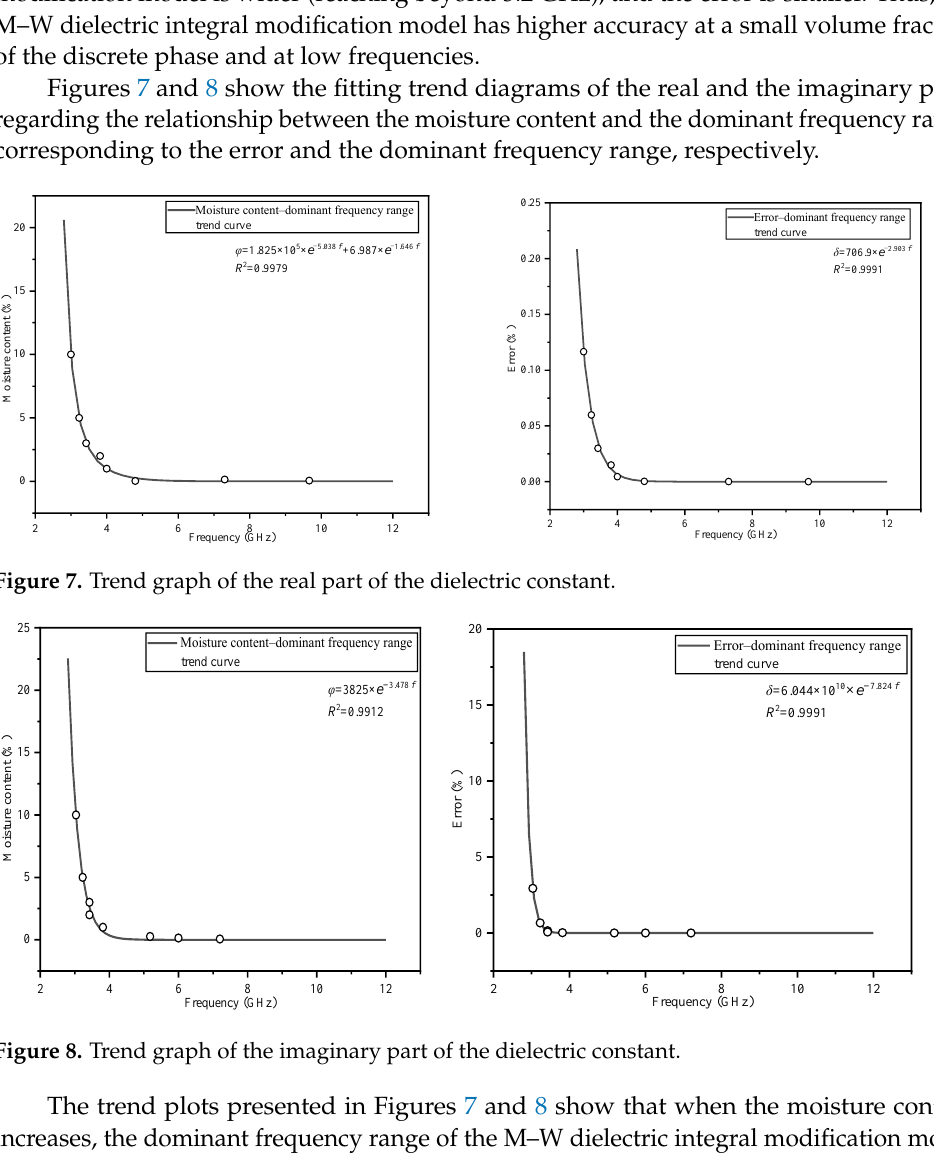
( h ) Figure 6. Error comparison of different models under multiple moisture contents. When the mois- ture content is 1% or less, the Lichtenecker logarithmic model, Rayleigh model, and series-parallel calculation formula have significantly higher errors than the Bruggeman symmetric model, so the error is omitted: ( a , b ) φ = 1%; ( c , d ) φ = 0.26%; ( e , f ) φ = 0.14%; ( g , h ) φ = 0.06%.